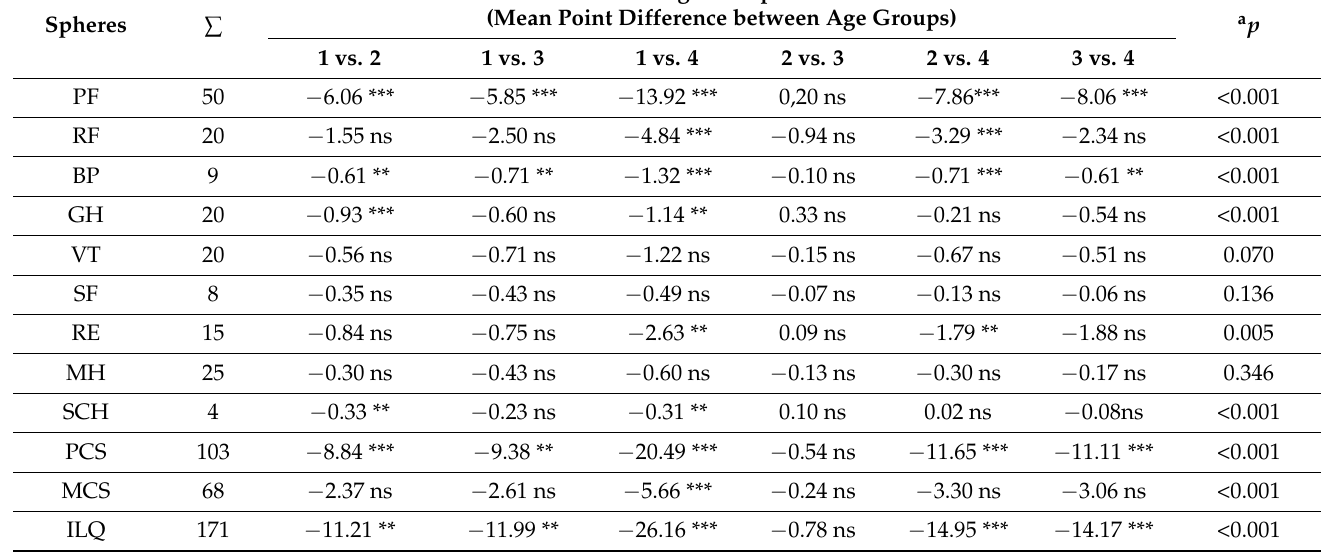
Table 6. Intergroup comparisons and the mean value of the difference between the compared groups (SF-36